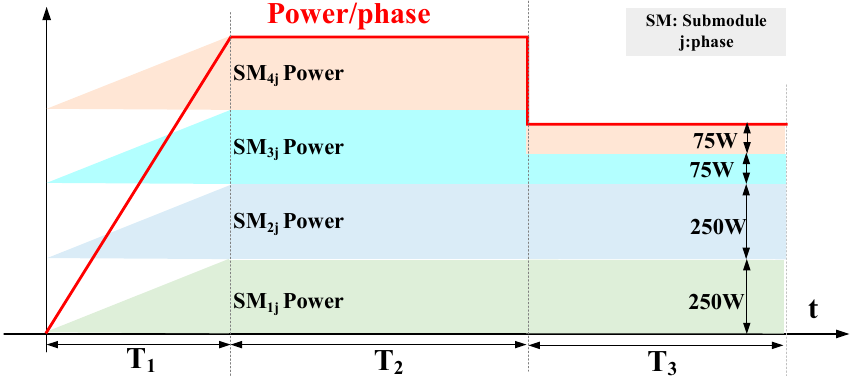
Figure 29. Power distribution of the SMs during Mode 4.